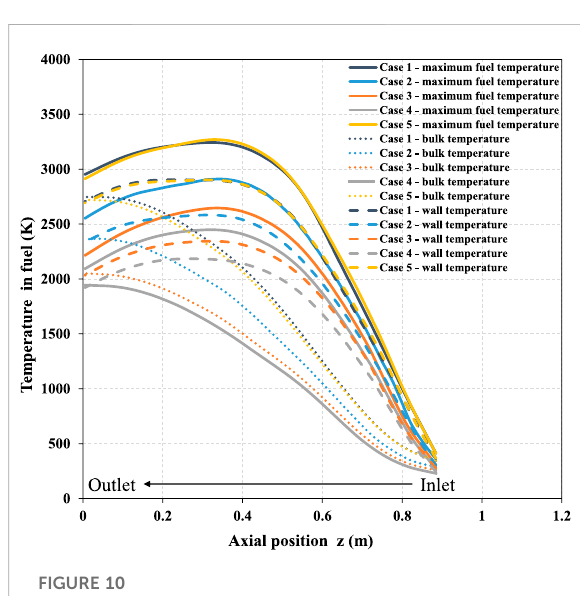
FIGURE 9 Axial linear heat power distribution of each channel in case 2.